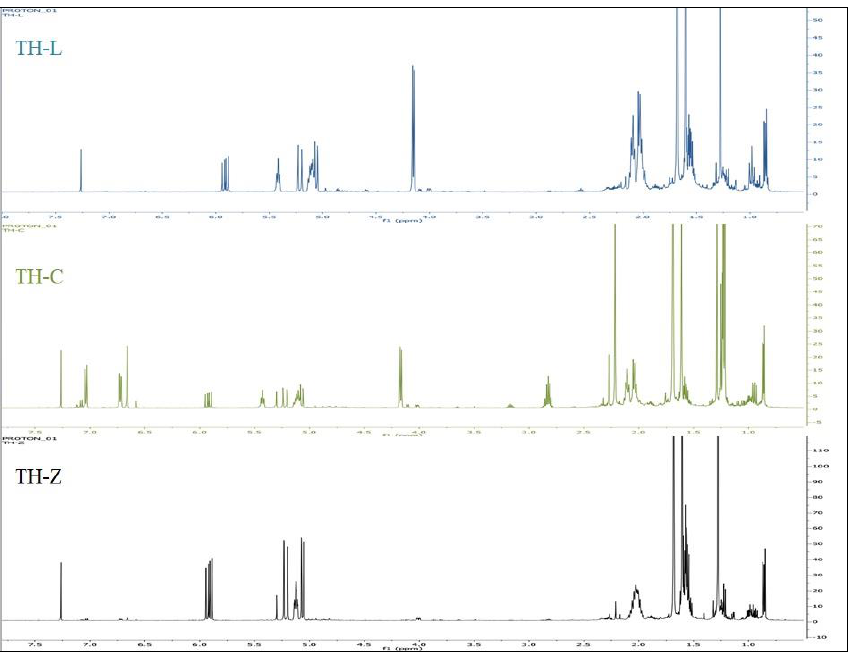
Figure 2. 1 H-NMR from the analysis of the essential oils of Thymus holosericeus collected from three Ionian Islands, Greece (TH-Z: Zakynthos; TH-C: Cephalonia, TH-L: Lefkada) during full-flowering (July 2018).